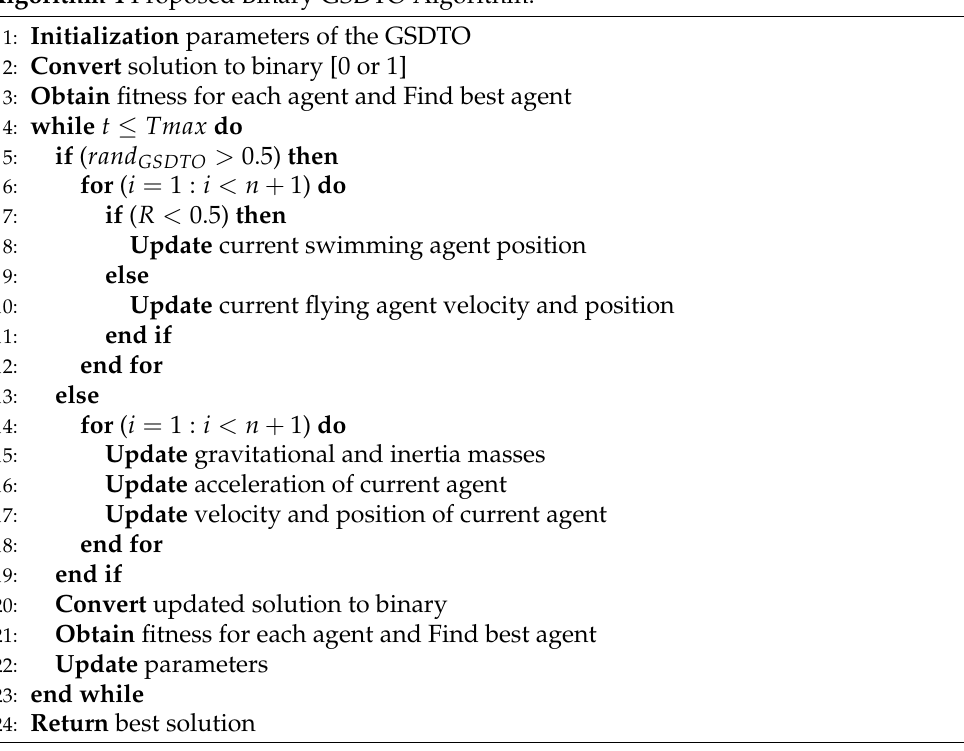
Figure 2. Sigmoid function to scale the output solutions to binary [0, 1]. Algorithm 4 Proposed Binary GSDTO